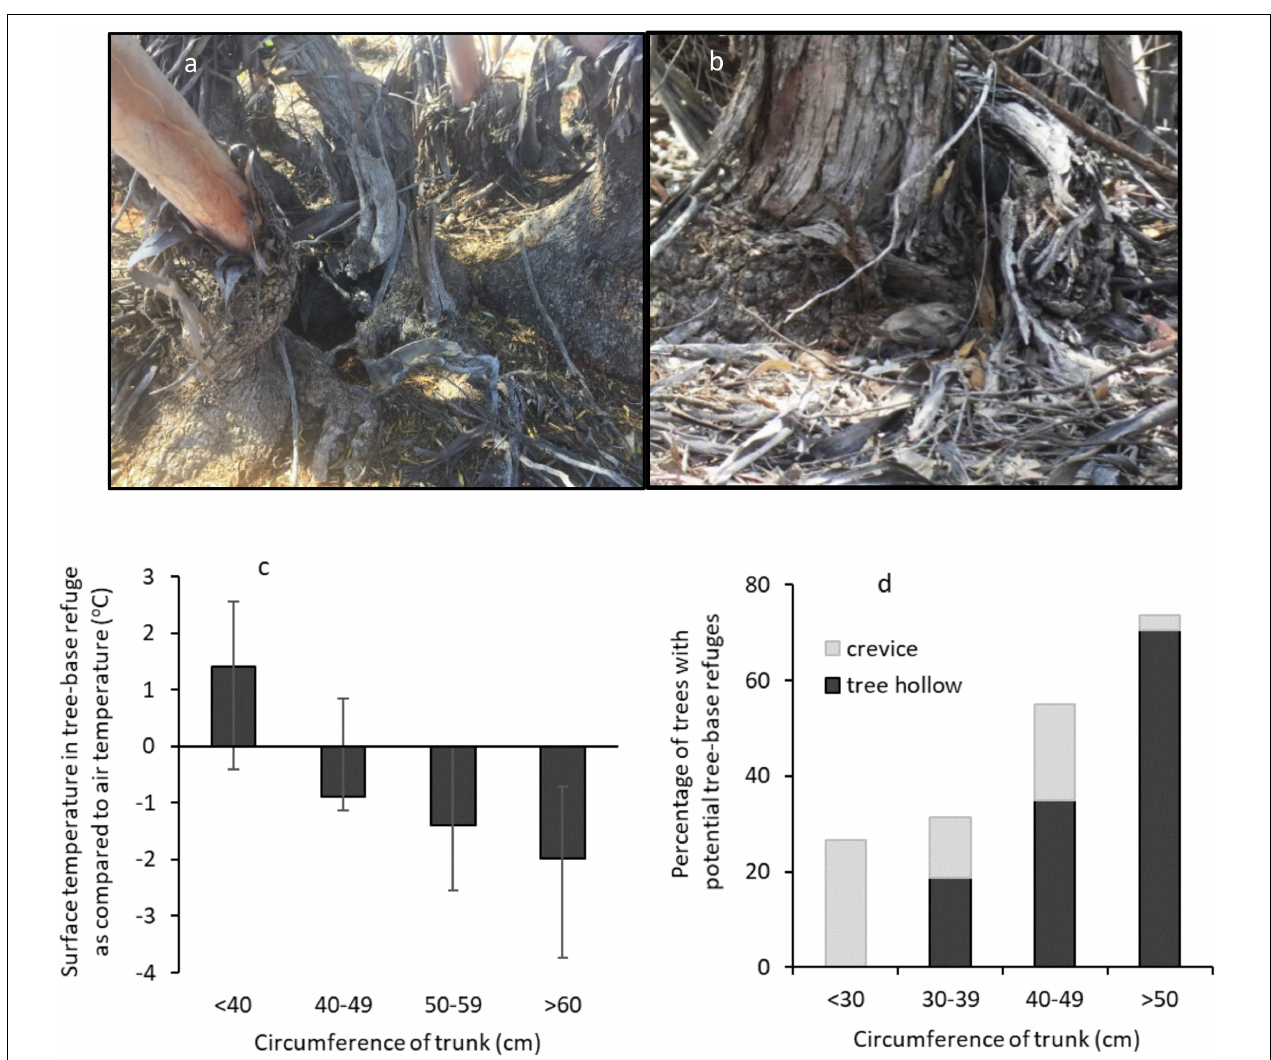
FIGURE 9 | Tree-base refuges: (a) a tree hollow and (b) a Jacky Winter sheltering in a crevice/depression. (c) Mean difference between the surface temperature in a tree-base refuge and air temperature (at a mean air temperature of 39.5 ◦ C) and (d) the percentage of mallee eucalypts with potential tree-base refuges, by tree size. Error bars show